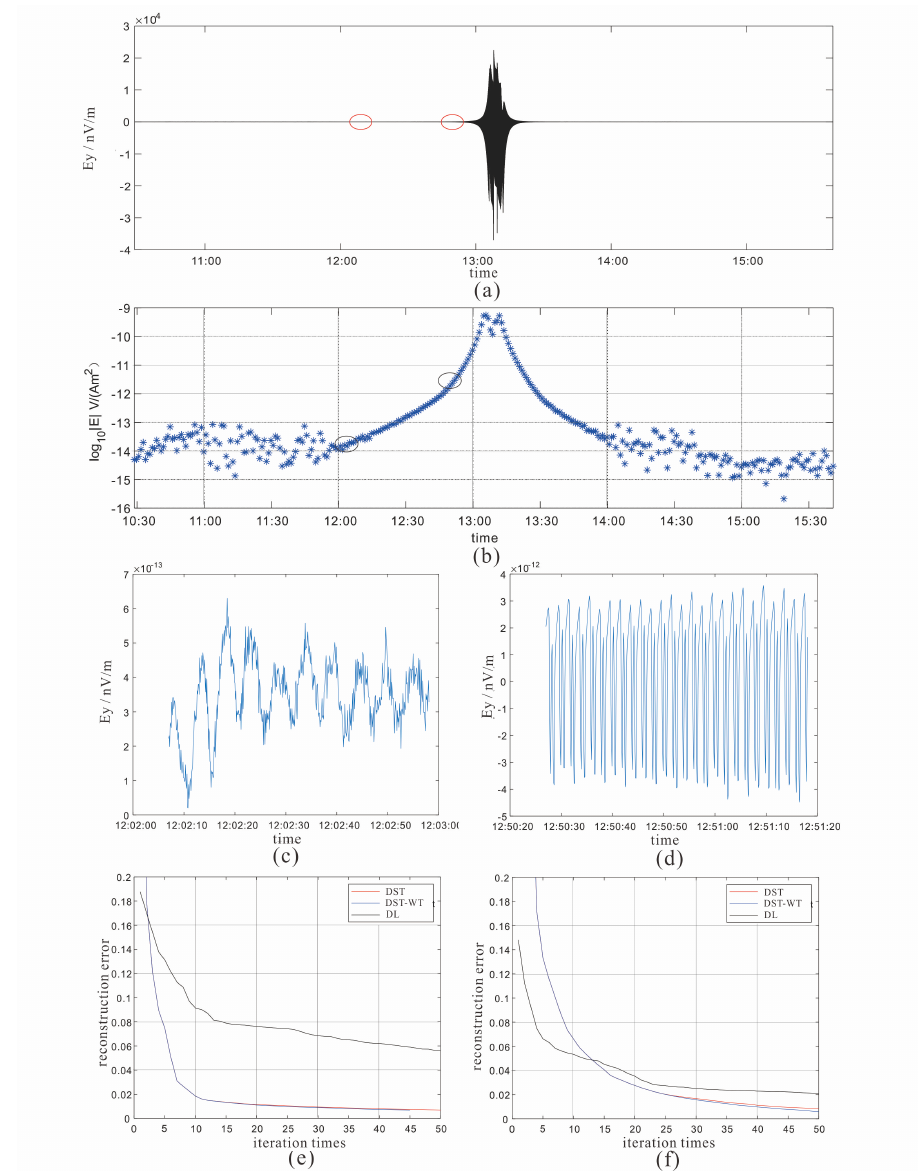
Figure 11. The characters of Ey component. ( a ) is the time sequence, ( b ) is the 0.5 Hz MVT plot, ( c , d ) are segments intercepted from ( a ), corresponding to red circles in ( a ), or the black circles in ( b ). ( e , f ) are the convergence performance under three dictionaries, in which red lines represent DST dictionary, blue lines represent DST-wavelet merged dictionary and black lines represent the learned